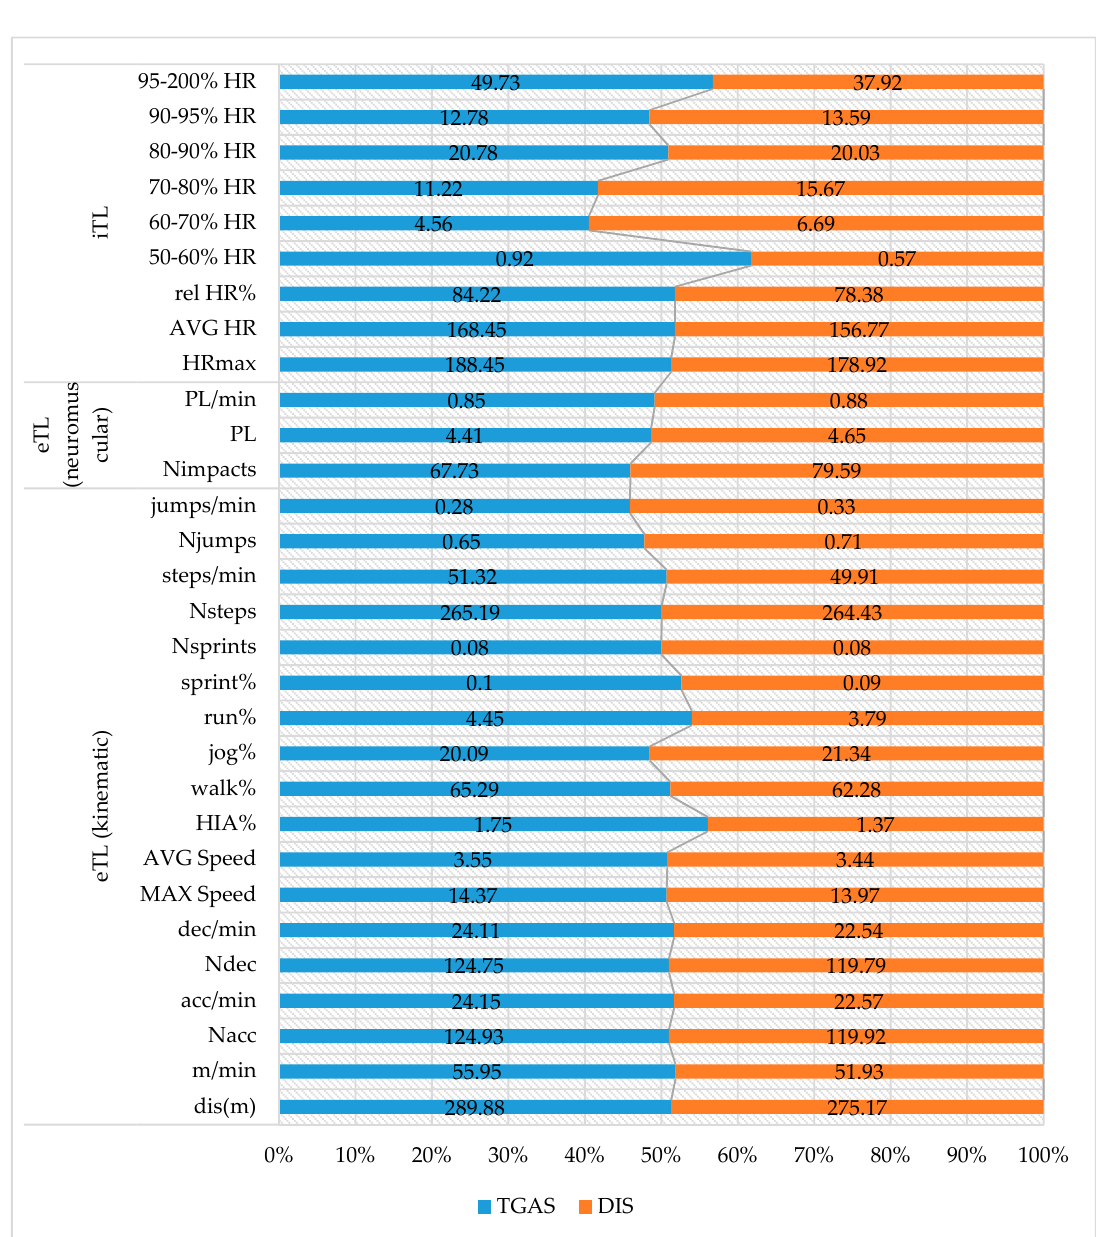
Table 2. Results of the application of the programs according to the teaching methodology.